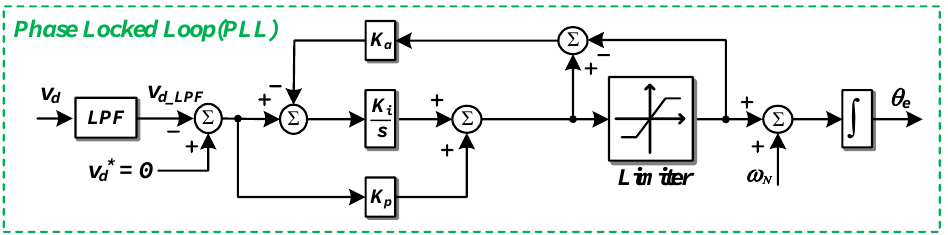
Figure 6. Control block diagram of phase detector using first order low pass filter and proportional integral (PI) controller.